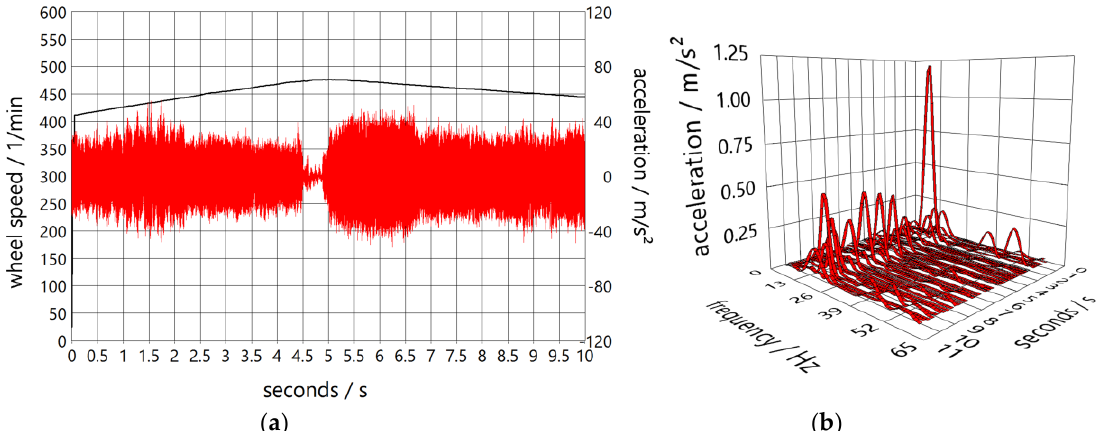
Figure 3. Comparative measurement data from a tram gearbox under varying operating conditions ( a ); and an associated short time Fourier transform to determine suitable frequency ranges for vibration energy harvesting ( b ).